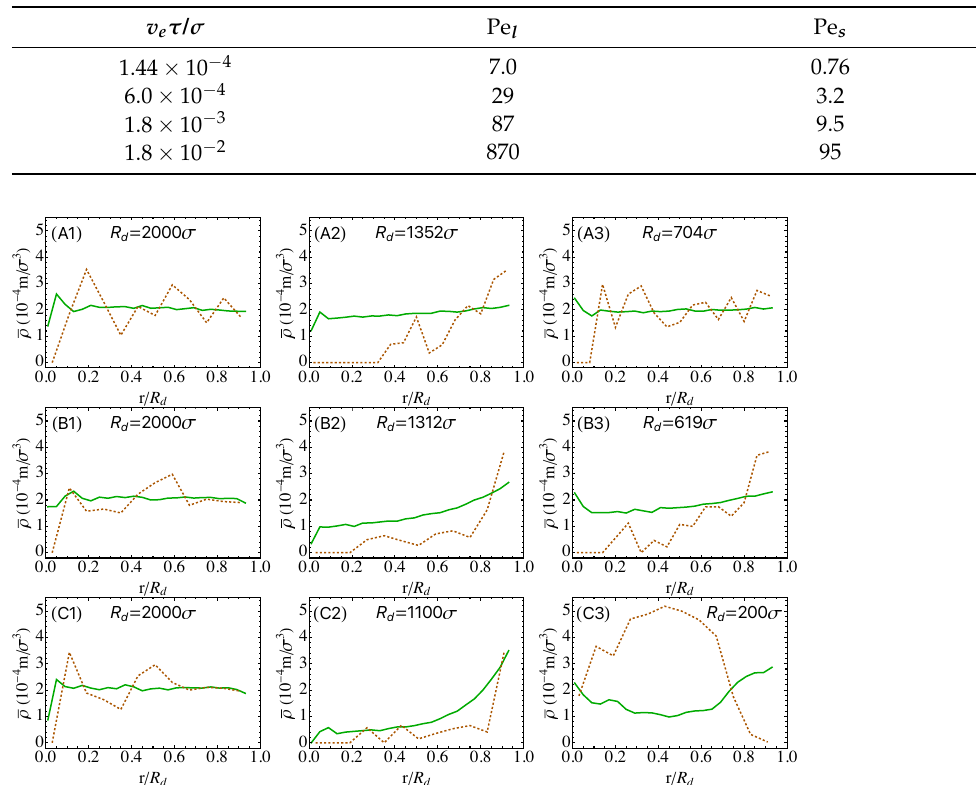
Figure 4. Density profiles of SNPs (solid green lines) and LNPs (dashed brown lines) in the droplet along its radial direction at various evaporation rates: v e = 1.44 × 10 − 4 σ / τ ( A1 – A3 ), v e = 6 × 10 − 4 σ / τ ( B1 – B3 ), and v e = 1.8 × 10 − 3 σ / τ ( C1 – C3 ). The stage of drying is indicated by the droplet radius ( R d